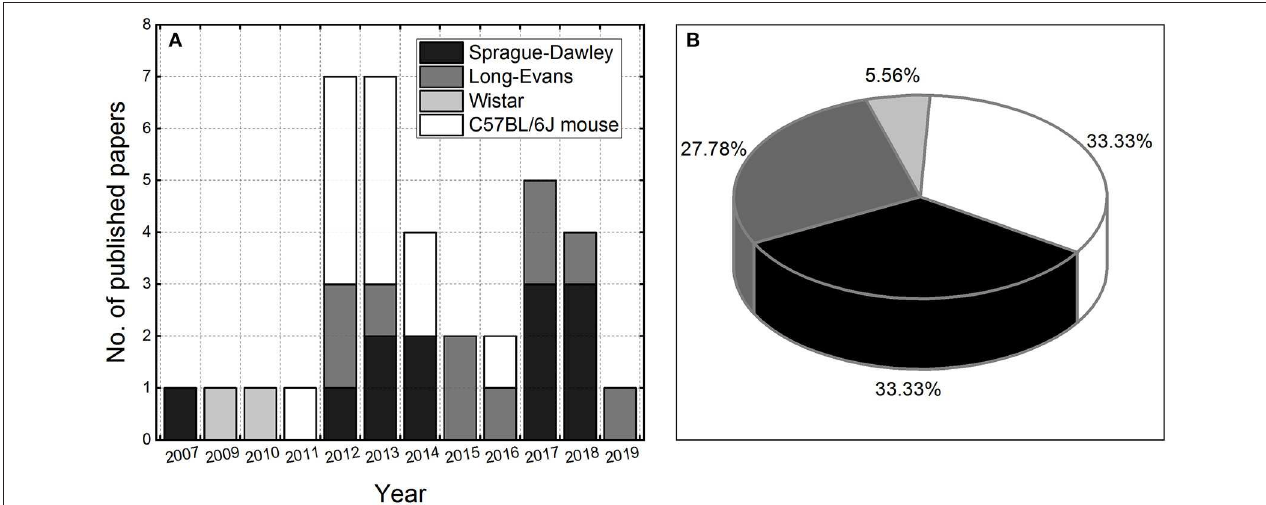
FIGURE 1 | The number of peer-reviewed papers published per year on repeated blast TBI using rodent models (A) . The pie chart illustrating the utilization of rodent models in rbTBI studies included in the analysis (B)